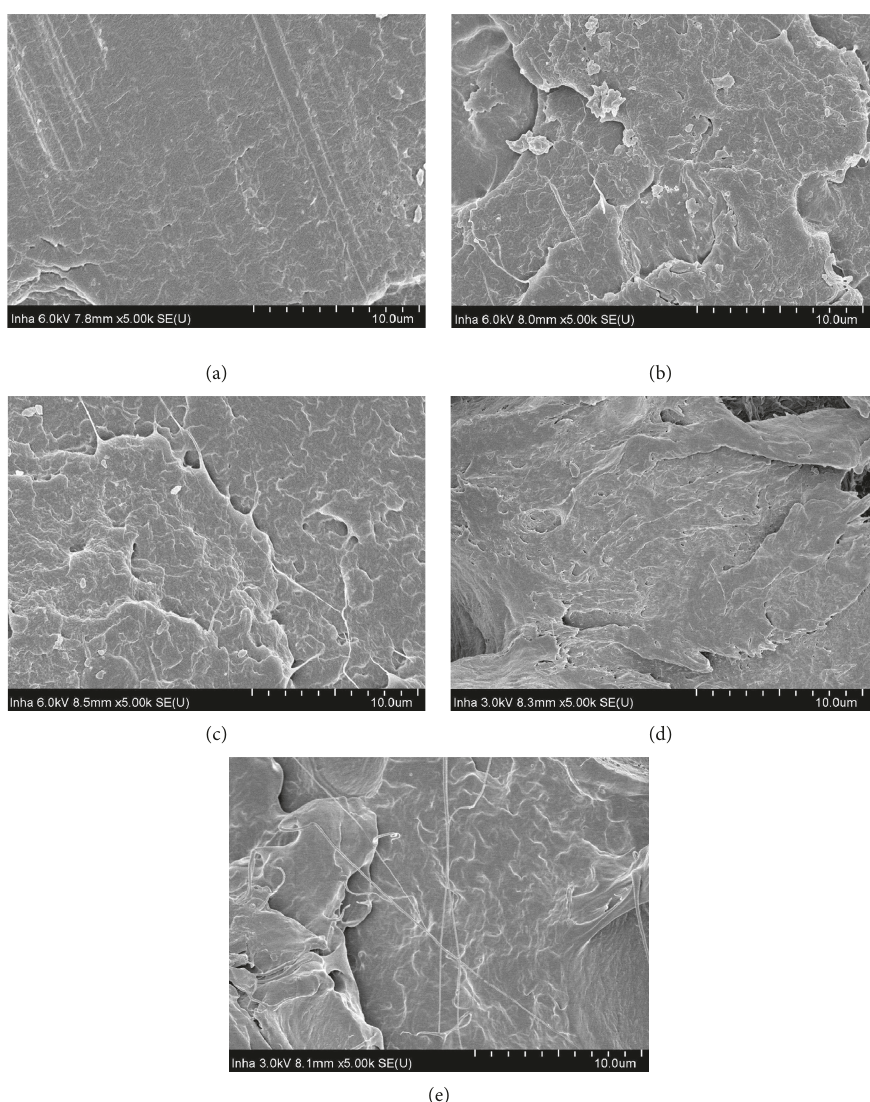
Figure 7: SEM micrographs of PLA/PCL blends after K IC tests: (a) neat PLA; (b) 1.25wt.% PCL; (c) 2.5wt.% PCL; (d) 5wt.% PCL; (e) 7.5wt.% PCL (magnification of